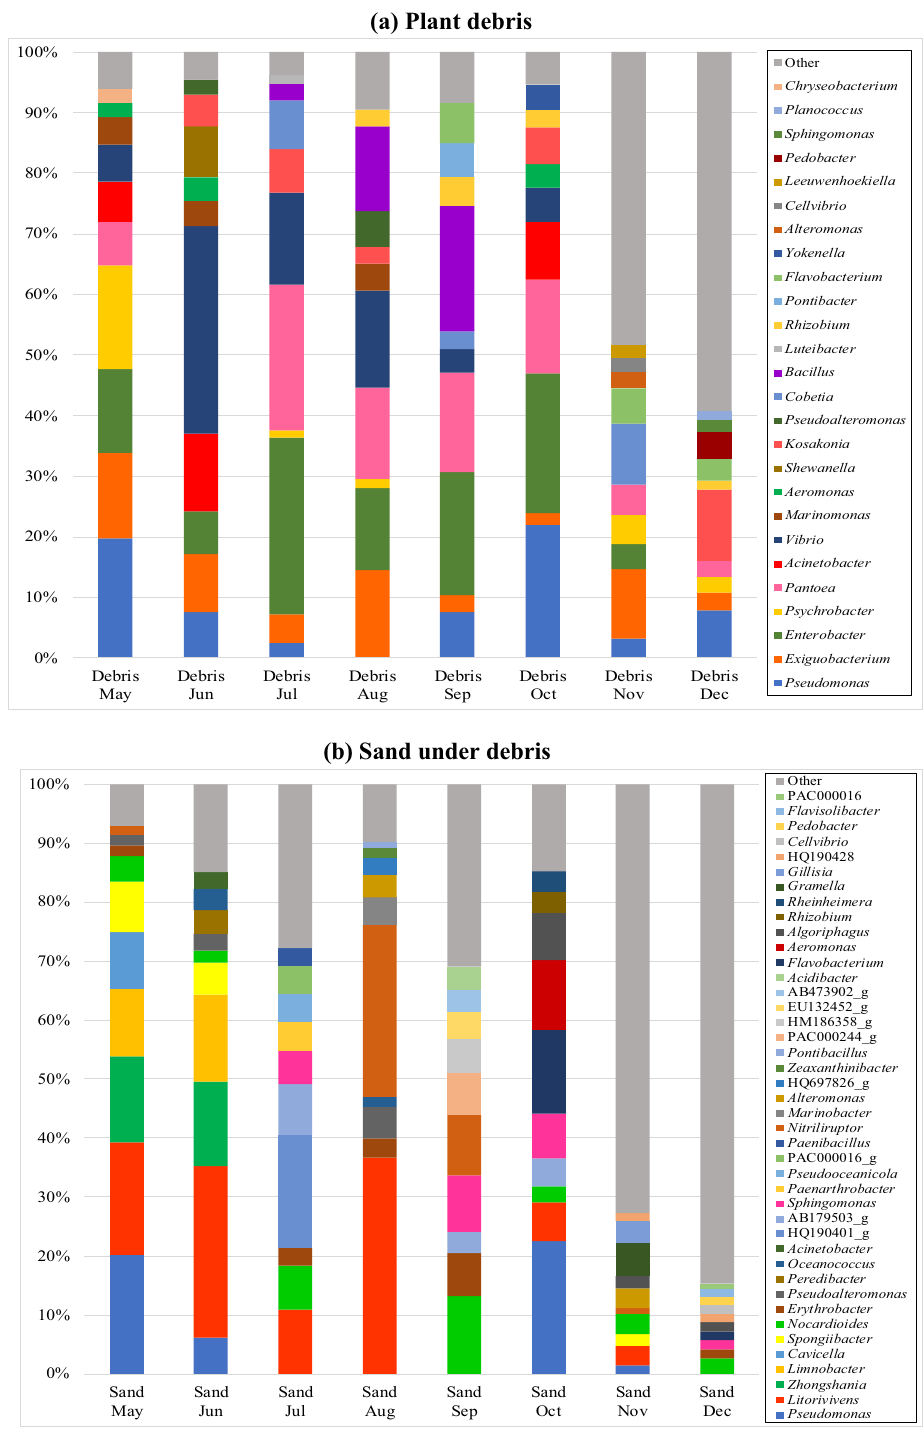
Figure 5. The distributions of the 10 most abundant Genera in these sample